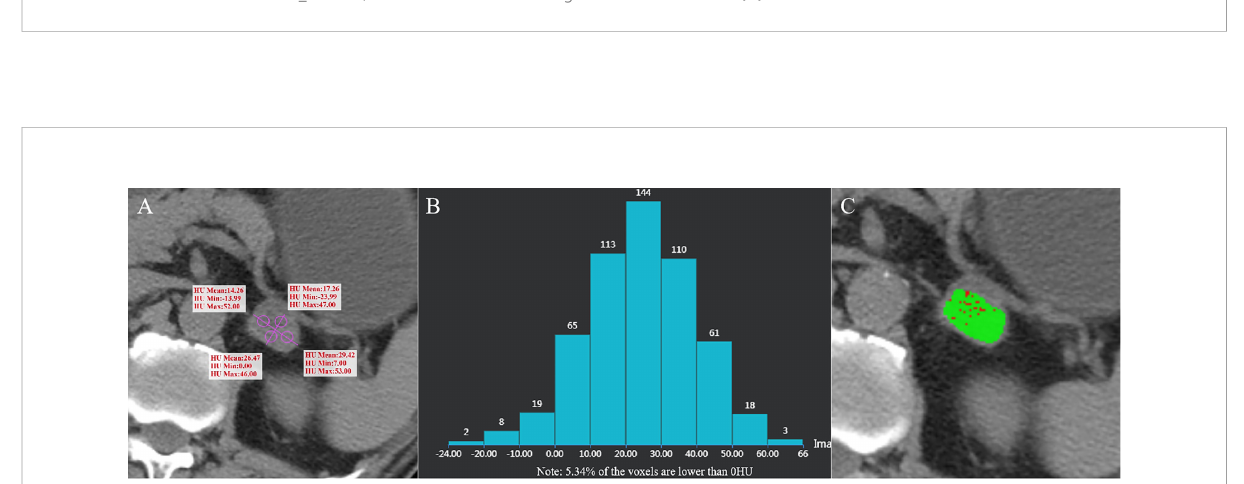
FIGURE 3 Adrenal adenoma of the left adrenal gland in a 62-year-old man. AV mean =21.853 HU (A) , AV min = -7.745 HU, and CTH negative pixel =5.34% (B) . The CT value in the red area is ≤ 10 HU, and the CT value in the green area is > 10 HU (C) .